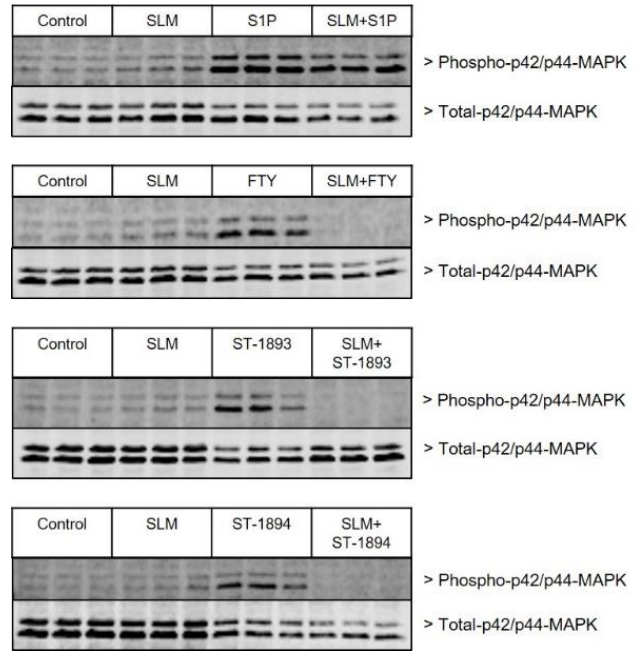
Figure 8. Effect of SK-2 inhibition on S1P, fingolimod, ST-1893, and ST-1894 on S1P 1 -induced p42/p44- MAPK phosphorylation. Starved confluent CHO-S1P 1 cells were pre-stimulated for 2 h with the SK-2 inhibitor SLM6031434 (1 μM), after which they were stimulated with 100 nM S1P, 1 μM fingolimod (FTY), 1 μM ST-1893, or 1 μM ST-1894 for 10 min. Cells were harvested for usual Western blot analysis, and membranes were probed with phospho- and total-p42/p44-MAPK antibodies. Presented blots are representatives of three independent experiments.